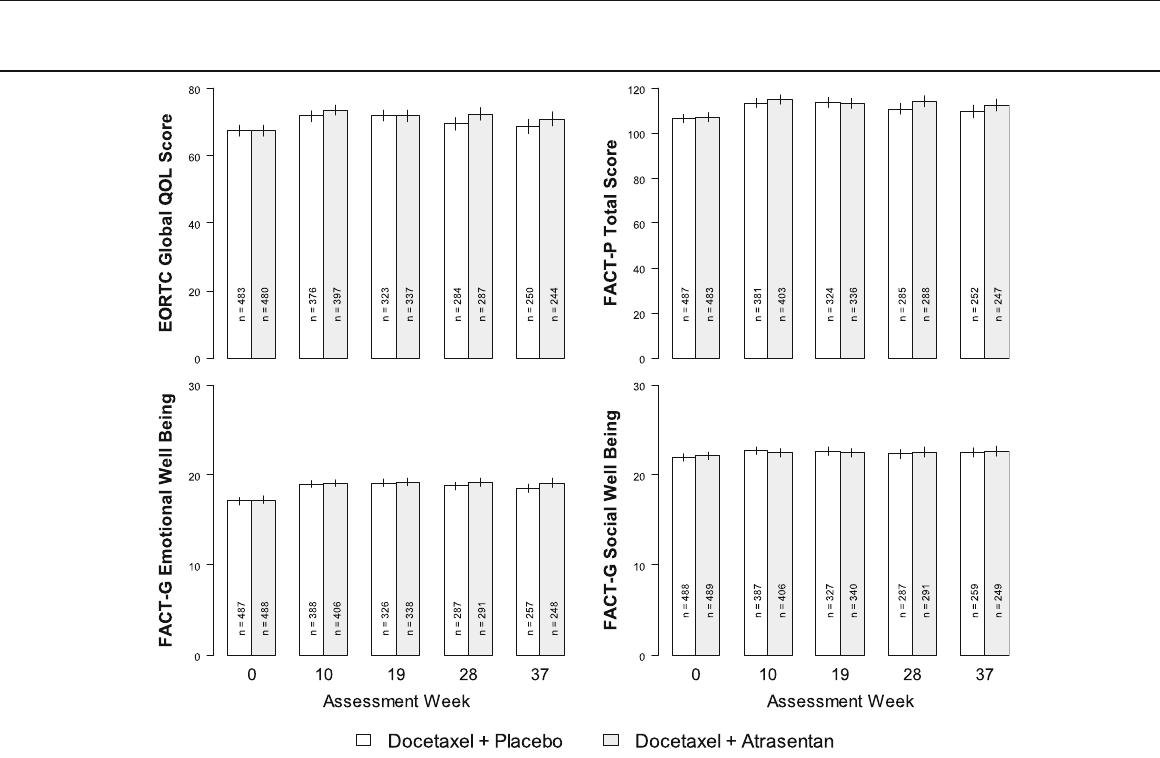
Fig. 3 Observed scores by arm over time for Global QOL, FACT-P Total Score, and FACT-G Emotional and Social Well-Being. Arm and assessment specific sample sizes are shown in the bars. Ninety-five percent confidence intervals for the observed rates are indicated by the vertical lines at the tops of the